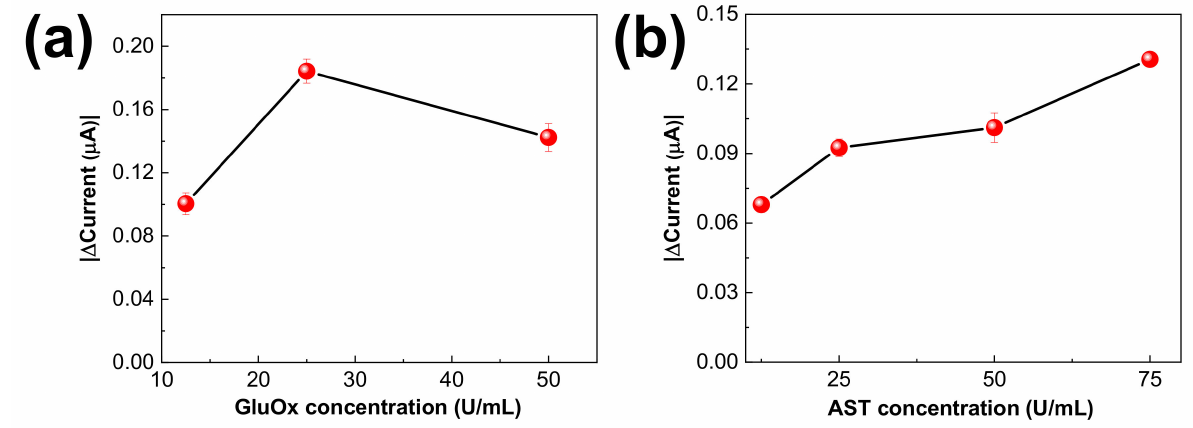
Figure 3. ( a ) Current changes to 0.1 mM glutamate using GluOxENs/PB/SPCE fabricated us- ing various concentrations of GluOx. ( b ) Current changes against 0.8 mM Asp using GluOx– ASTENs/PB/SPCE fabricated using 25 U/mL GluOx and various concentrations (i.e., 12.5, 25.0, 50.0, and 75.0 U/mL) of AST in the presence of 150 µ M ketoglutarate in the buffer.